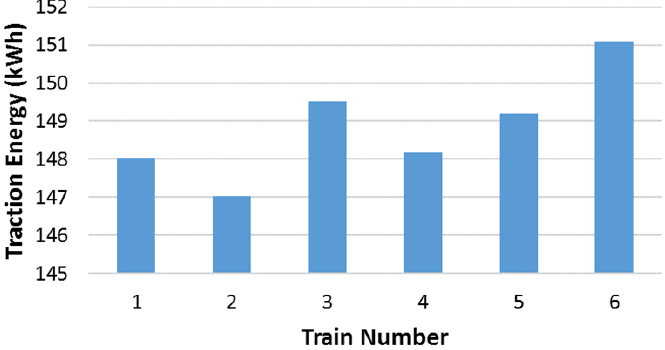
Figure 17. The traction energy of the trains running on a single track.